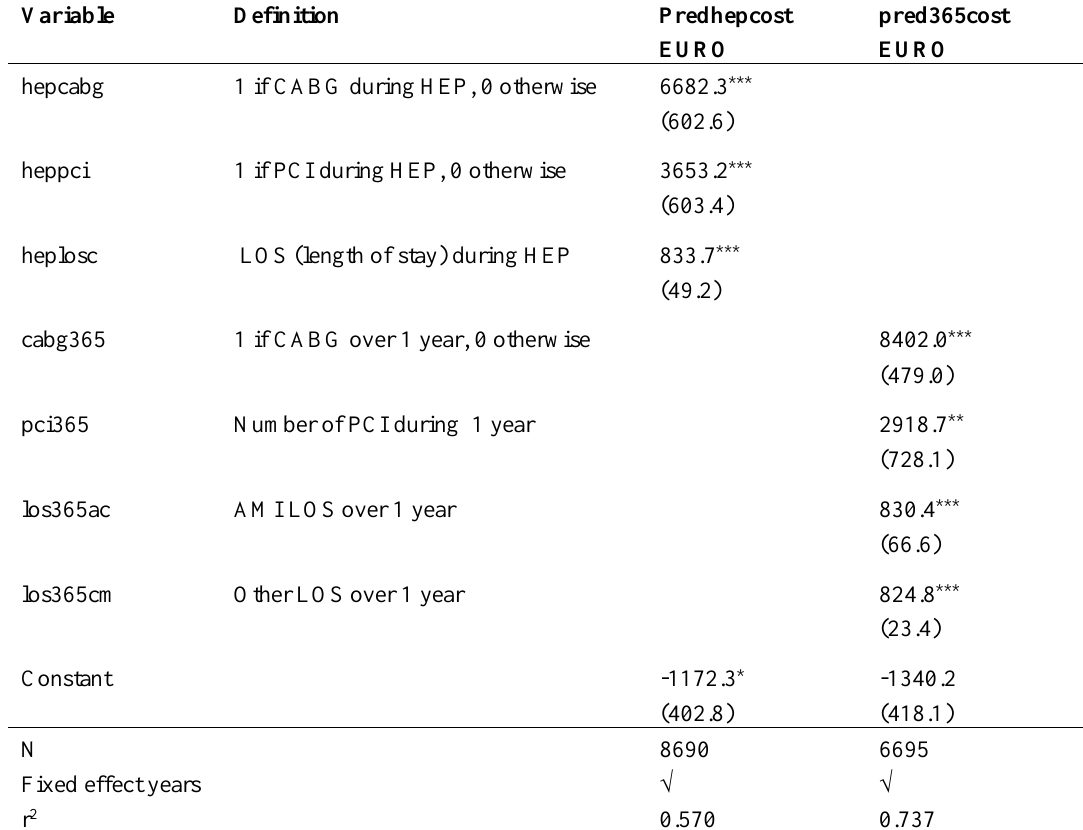
Table 3: Cost regression from Finnish micro data